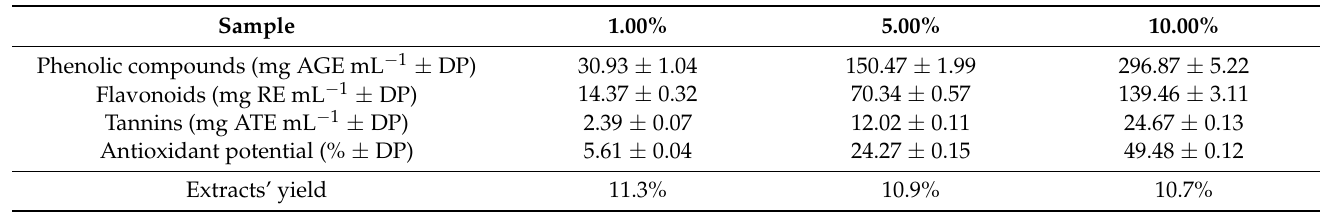
Figure 5. Flowchart of the action of aqueous extracts of M. albicans (1%, 5%, and 10%) on the life cycle of P. xylostella . * Effect only occurred at the 10% concentration. Table 6. Data on phenolic compounds, flavonoids, tannins, antioxidant potential, and yield of botanical extracts of Miconia albicans